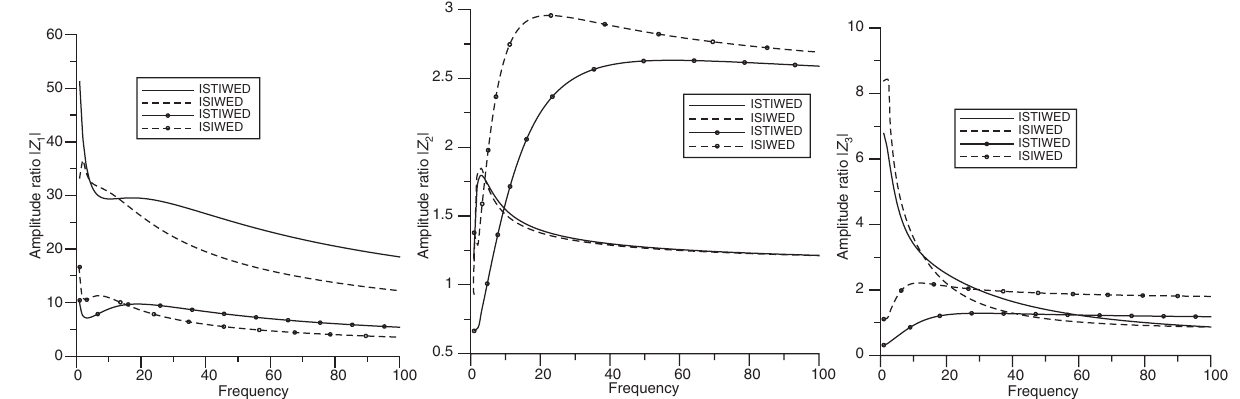
| ( i = 1, 2, 3) with frequency for incident qT-wave. i